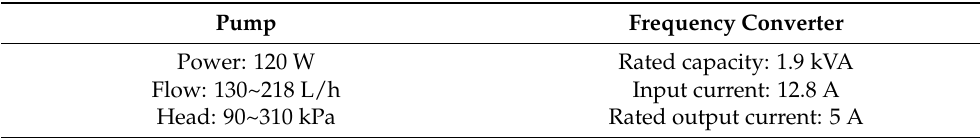
Table 2. Performance parameters of the pump and frequency converter.